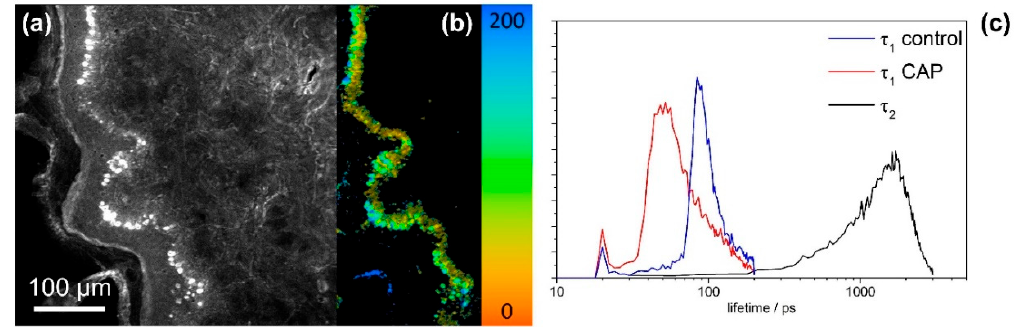
Figure 4. ( a ) TPEF image of the human skin tissue section treated with the kINPen MED ® plasma device for 10 s with an Ar–oxygen working gas. Excitation at 670 nm, emission 458 / 64 nm. ( b ) 2P-FLIM image of lifetime component t 1 fitting the data of (a) with a bi-exponential decay function using a threshold of 20 and bin 1 in order to fit the brightest pixels within the melanocytes inside the stratum basale only. ( c ) Histograms of the lifetime t 1 before and after CAP treatment and of t 2 after CAP treatment.